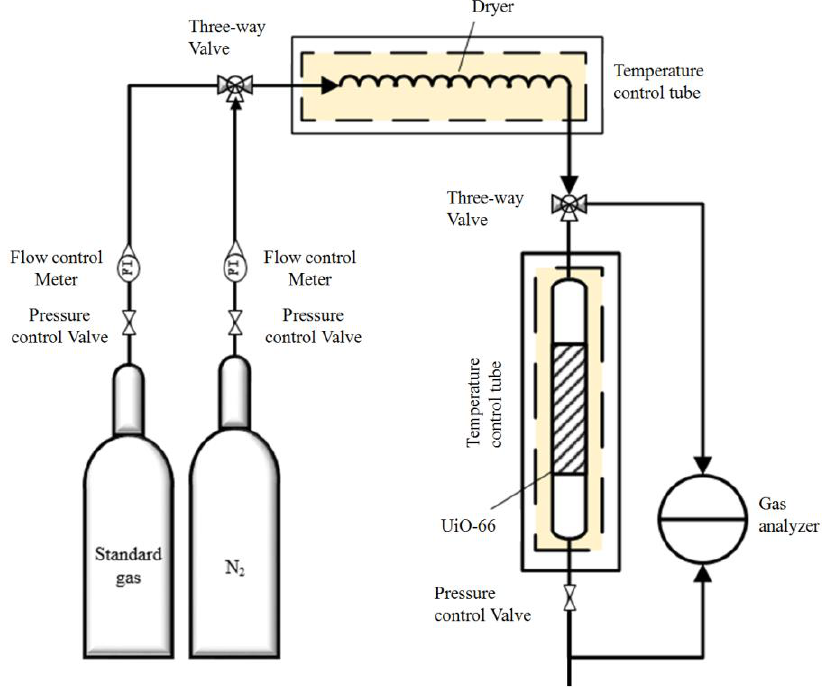
Figure 2. Apparatus for gas adsorption